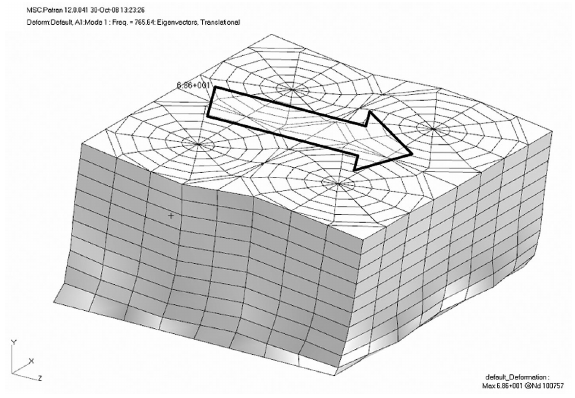
Fig. 15. 1st and 2nd mode: 765 Hz – X,Z Symmetric translation (single cell 641 Hz).